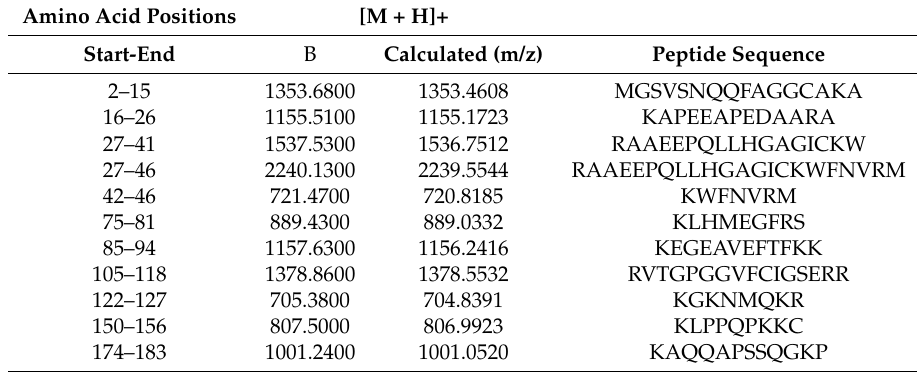
Figure 5. Liquid chromatography-mass spectrometry (LC-MS). ( a ) Isoelectric point (pI) of cLin-28 protein according to different scale calculations. ( b ) 2D-gel SDS page. ( c ) MLDI-TOF MS-derived peptides (red) matched to the sequence of cLin-28 protein. ( d ) Observed peak list of peptides from the cLin-28 protein. Table 2. Observed and calculated ions of peptide masses of cLin-28